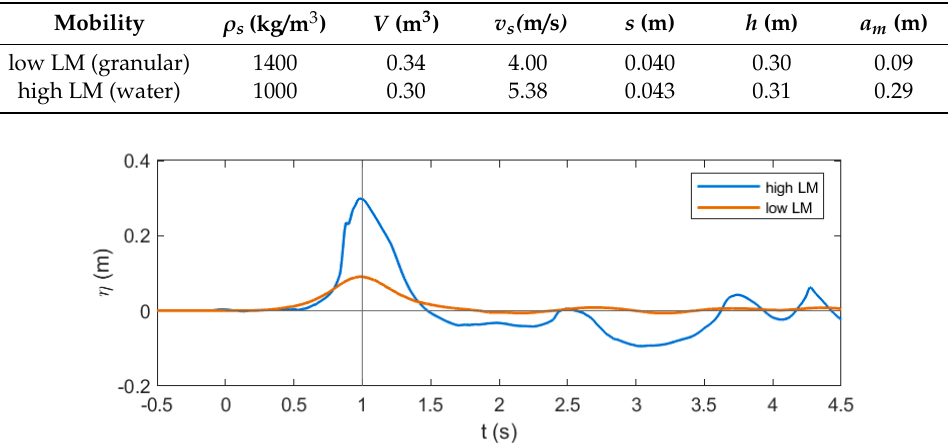
Figure 3. Example time series of water surface elevation near the impact site for landslides with low and high mobility, adjusted such that the maximum amplitude occurs at t = 1 s. These waves were observed at wave probe P1 and correspond to the experimental conditions listed in Table 1.